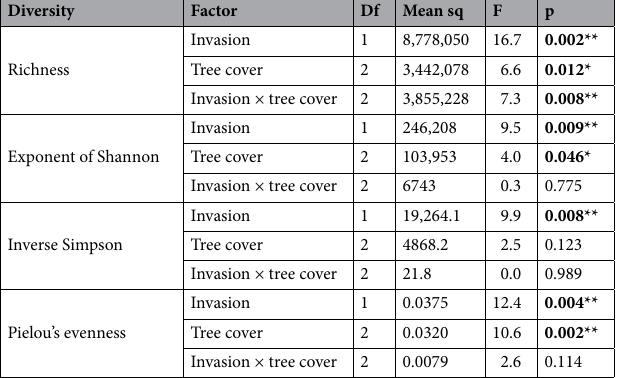
Table 2. ANOVA results on the differences in diversity of microbial communities between patches invaded and uninvaded by O. stricta under the canopies of V. nilotica and S. africana and in open patches with no tree cover. Significance indicated in bold as follows: *p < 0.05; **p < 0.01.